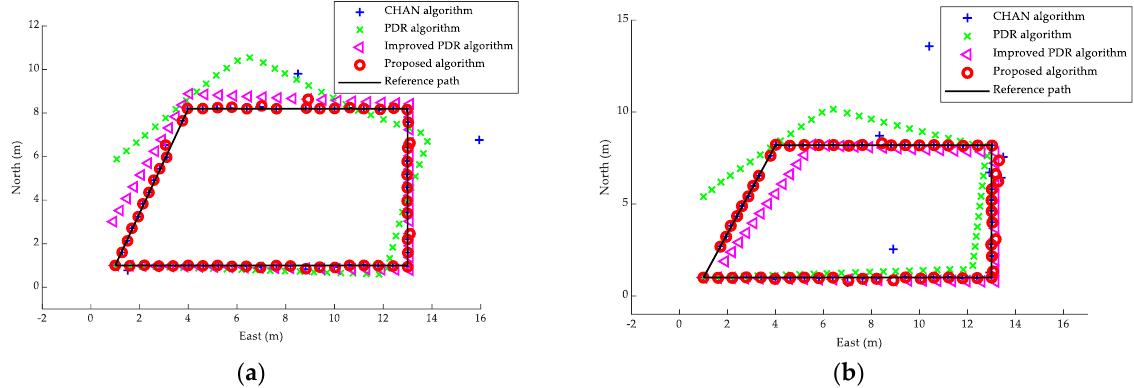
Figure 15. Localization path results among CHAN, PDR, improved PDR, and the proposed algorithm with two different height pedestrians. ( a ) Volunteer #1 (height 155 cm). ( b ) Volunteer #2 (height 180 cm).